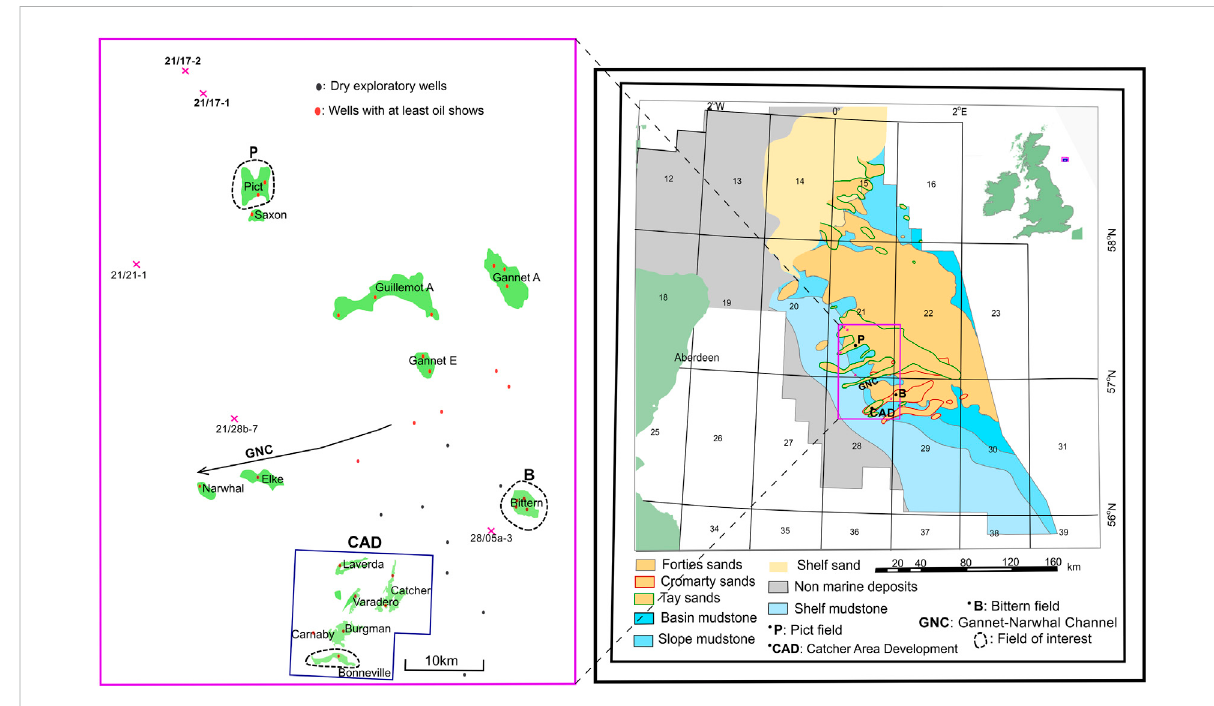
FIGURE 1 Regional map highlighting the distribution of Tay, Cromarty and Forties sandstone members in the Central North Sea. The location of the Bittern, Pict and Bonneville fi elds are also highlighted. These fi elds have identi fi ed and cored oil water contacts. The cores are collected through the oil leg into the water